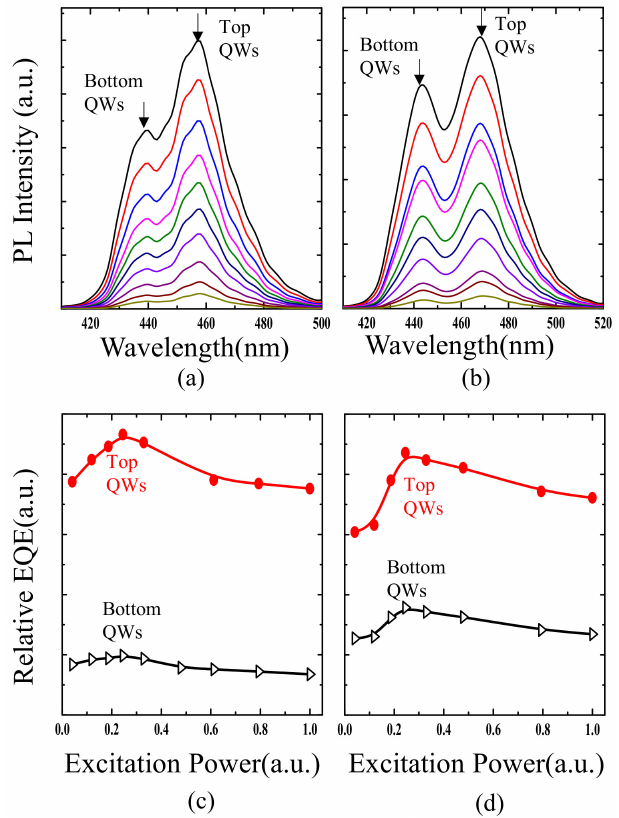
Figure 7. Power-dependent PL spectra of sample A ( a ) and B ( b ), excitation power density-dependent relative quantum e ffi ciency for sample A ( c ) and B ( d ).